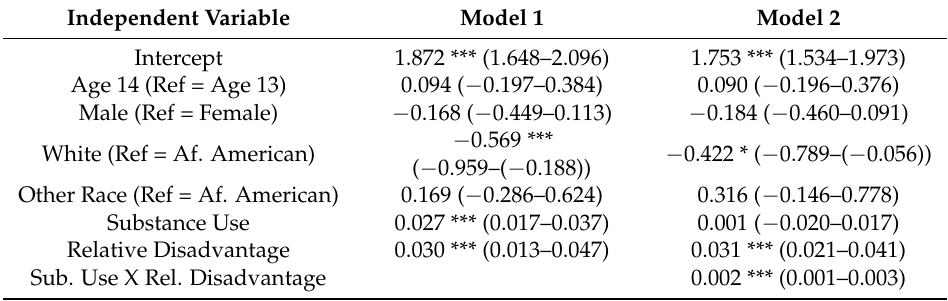
Table 1. Generalized estimating equations (GEE) models of momentary stress ( n = 1617). Model 1 shows the direct effect of relative disadvantage and Model 2 shows the moderation of that effect by substance